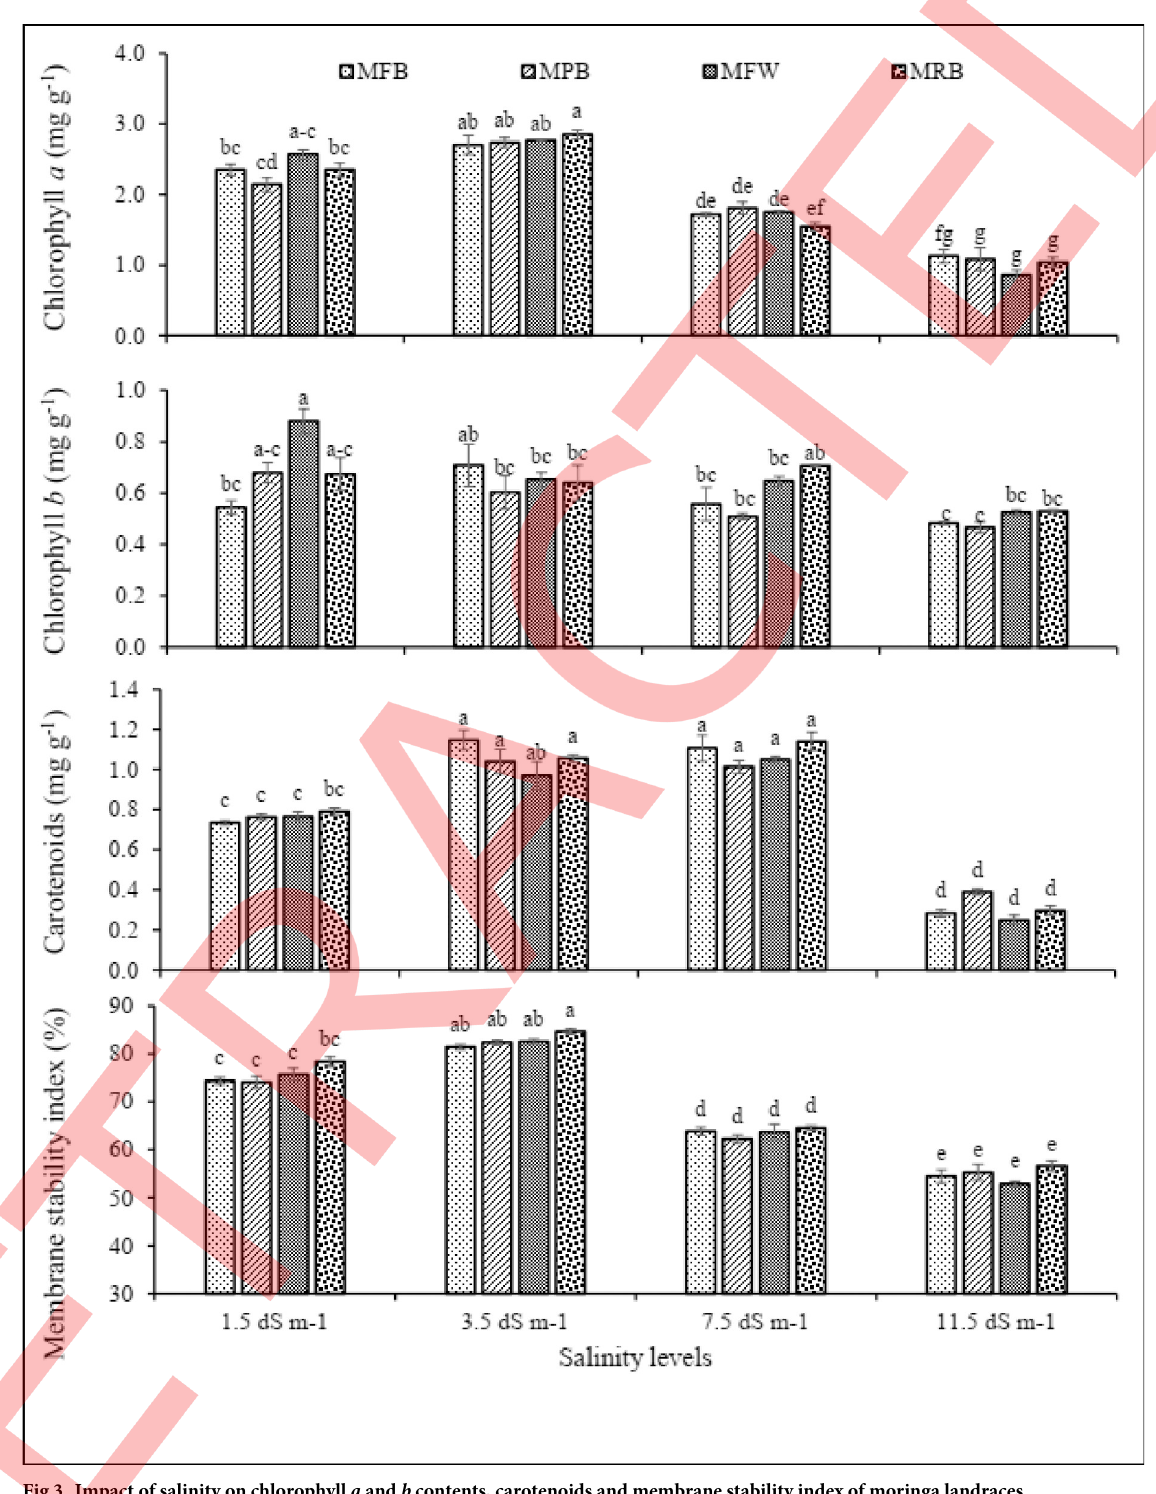
Fig 3. Impact of salinity on chlorophyll a and b contents, carotenoids and membrane stability index of moringa landraces.